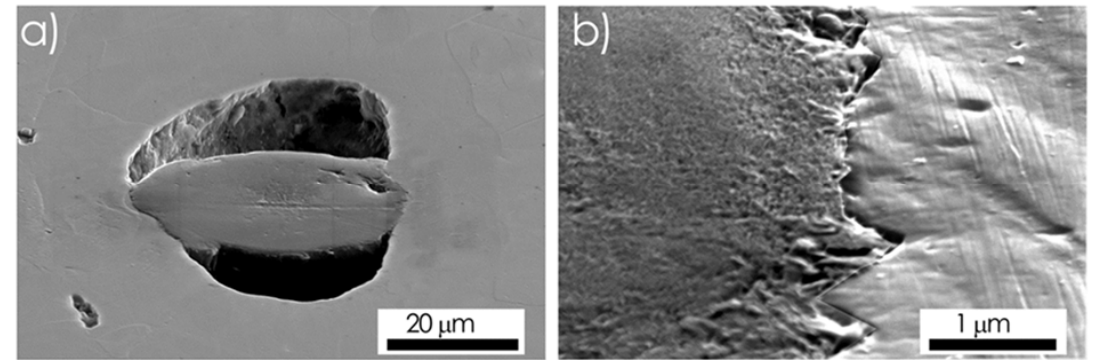
Figure 8. Debonding area at the G ‐ M interface in SNi9 specimen, around a spheroid located near fracture, SEM: ( a ) A pure G ‐ M debonding at poles of spheroid, ( b ) a zig ‐ zag profile at the G ‐ M interface, traces of deformation inside the ferritic matrix.